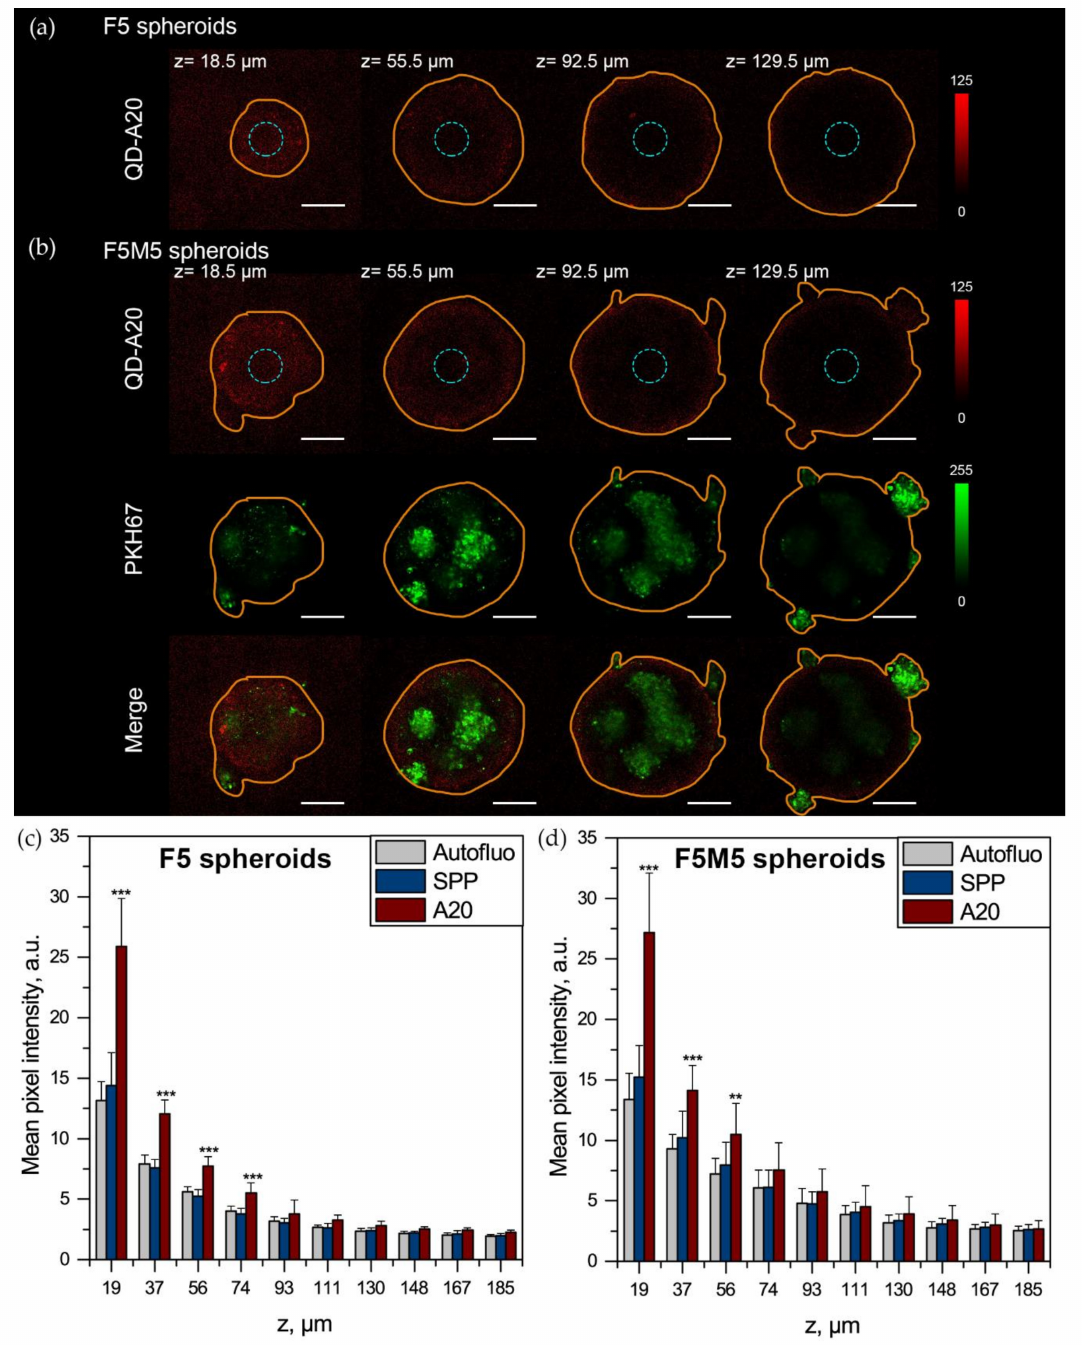
Figure 6. 3D Fluorescence imaging of QD-loaded head and neck squamous cell carcinoma (HNSCC) spheroids. 3D confocal microscopy of QD-A20 (red color, λ em = 730–800 nm) distribution in di ff erent optical sections of ( a ) F5 and ( b ) F5M5 spheroids, incubated for 3 h with 50 nM of QDs. MeWo cells were pre-stained with PKH67 membrane dye (green color, λ em = 530–600 nm). The orange line displays the contour of spheroid. The mean pixel intensity of the central region (blue circles) of ( c ) F5 and ( d ) F5M5 spheroids 3 h post-incubation with 50 nM of QDs as a function of the depth (z) of optical section. Scale bar = 100 µ m. Data represent mean ± SD (n = 3–7; ** p < 0.01; *** p < 0.001 compared to autofluorescence, using